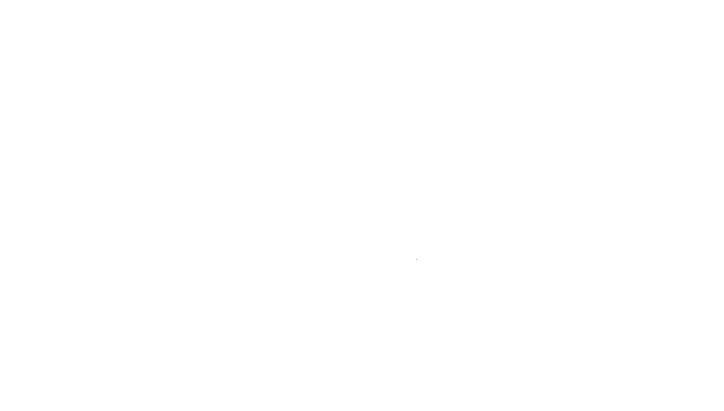
Flow chart of selection.